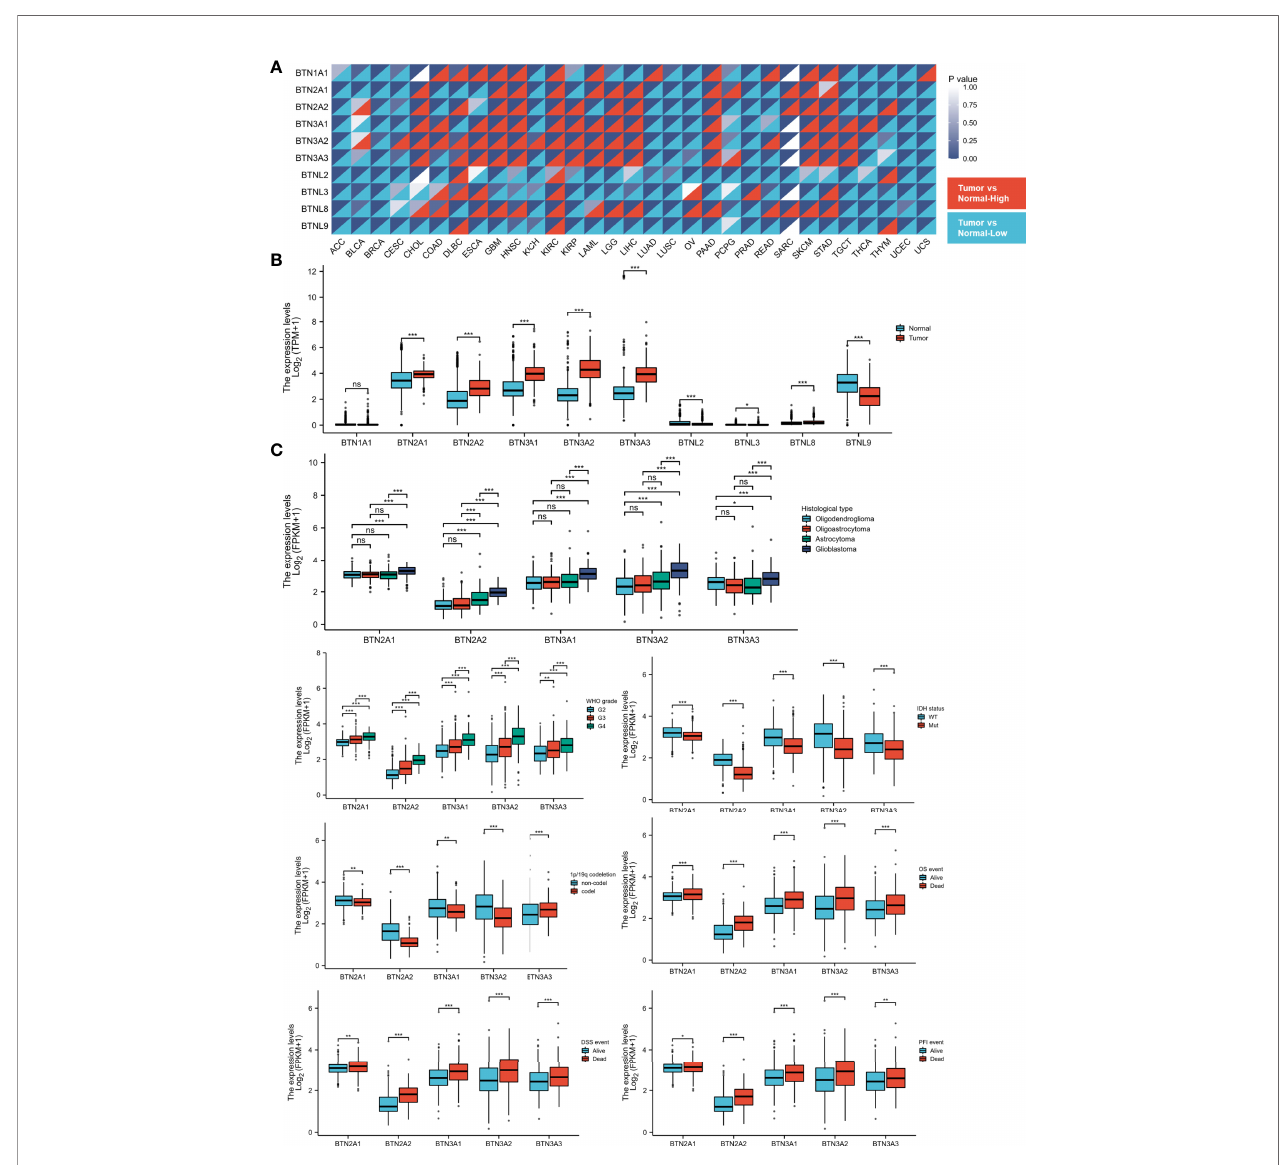
FIGURE 1 | Expression of BTN/BTNL and BTN2/3 in pan-cancer and pan-glioma. (A) BTN/BTNL expression levels in different tumor types from TCGA database were determined by R software. Each cell in the heatmap displays the p-value at the upper right and the expression status at the lower right. The high expression in the tumor corresponds to red, and the low expression corresponds to blue. (B) BTN/BTNL expression levels in TCGA-GBMLGG merge cohort. (C) Correlation between BTN2/3 subfamily expression levels and clinicopathological characteristics (histological type, WHO grade and IDH status, and survival events). BTN, butyrophilin; BTNL, butyrophilin-like; TCGA, The Cancer Genome Atlas; GBMLGG, glioblastoma and low-grade glioma. *P < 0.05; **P < 0.01; ***P < 0.001; “ ns ” stands for “ no signi fi cance ”